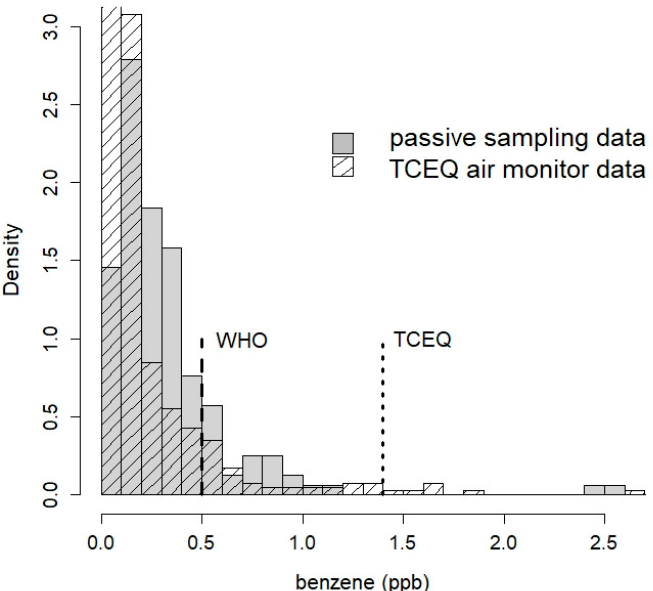
Figure 9. Histograms of our passive sampling data (grey bars) across all sites, compared to ran- domly selected hourly data of similar sample size and periods from the Karnes City air quality monitoring station (hashed bars). Indicated via a vertical dashed line is the WHO guidance value for benzene (0.5 ppb), and via a dotted line the TCEQ air monitoring comparison value (AMCV) for benzene (1.4 ppb).